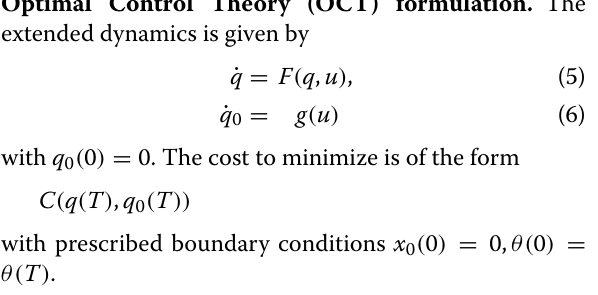
Problem 1 The cost is taken as C = q 0 ( T ) and we have x 0 ( T ) = x T where x T is